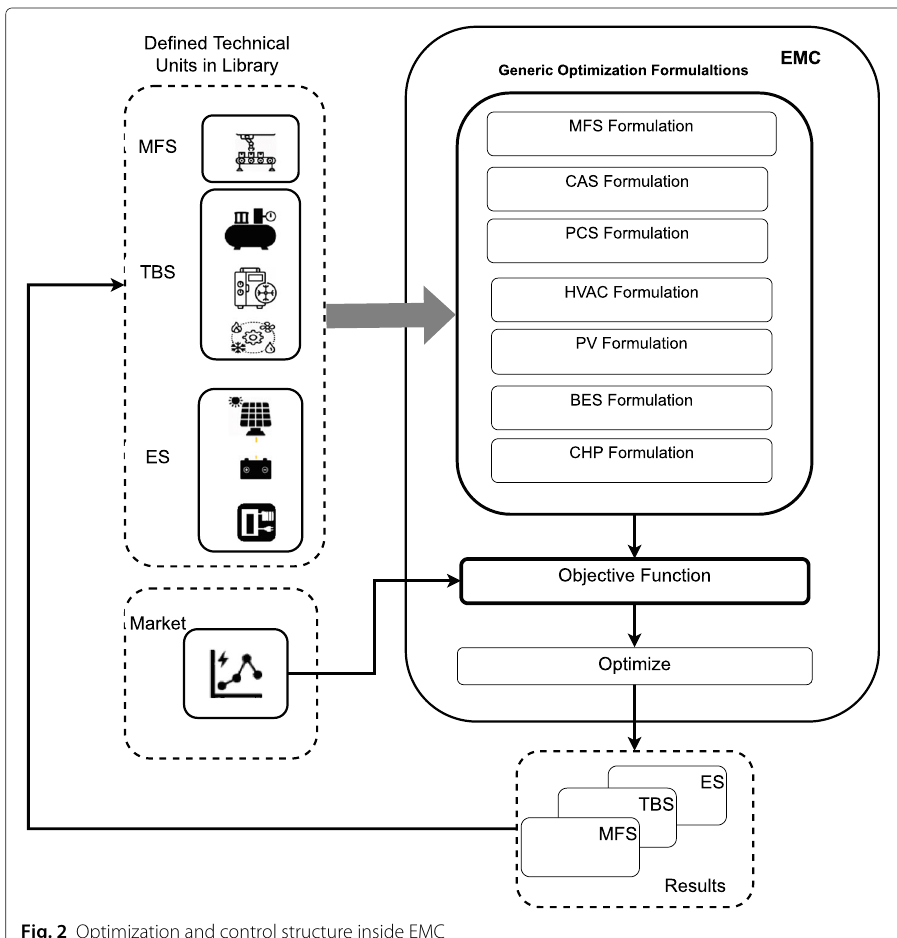
Fig. 2 Optimization and control structure inside